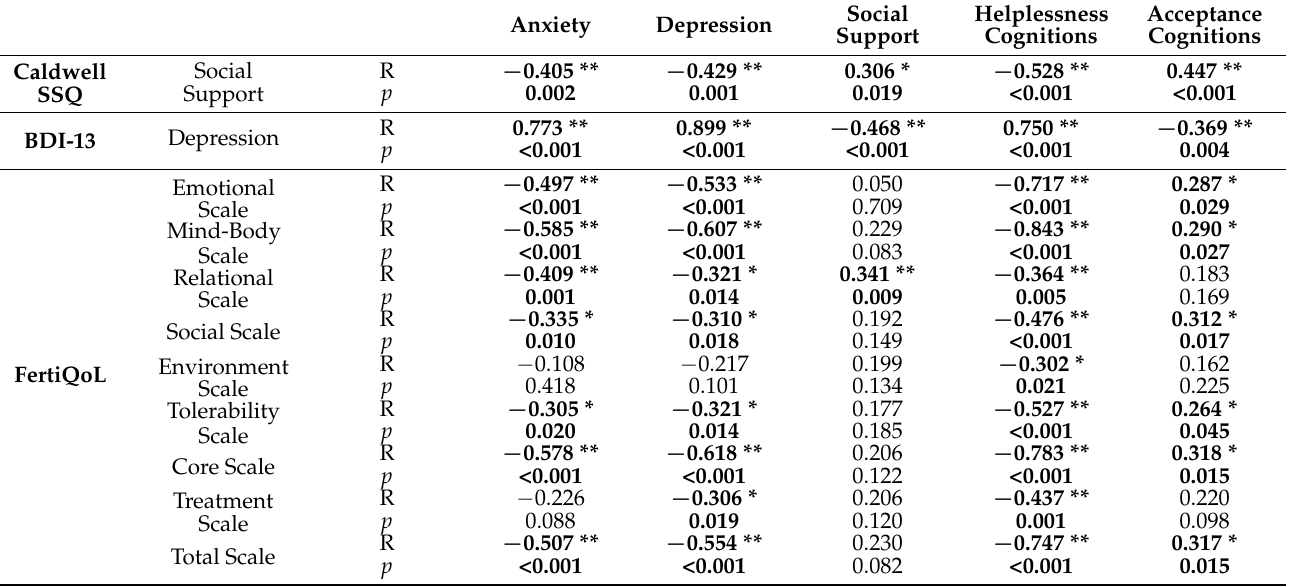
Table 5. Criterion validity of the SCREENIVF compared to FertiQoL, Caldwell Social Support Ques- tionnaire, and Beck Depression Inventory (BDI-13) based on Spearman’s rank correlation